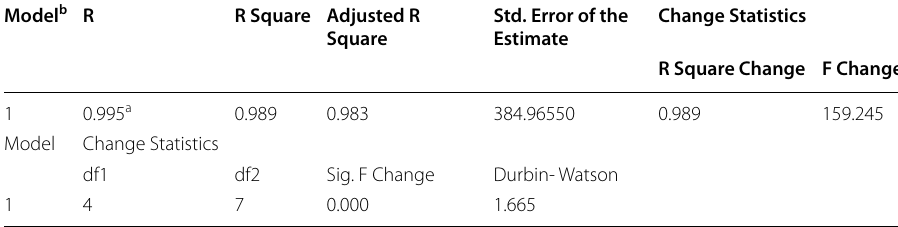
Table 3 Model summary